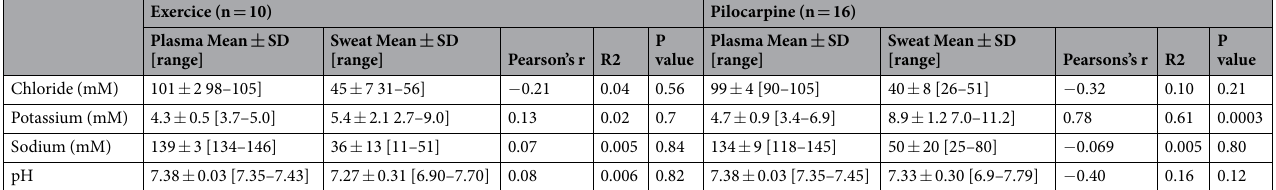
Table 1. Electrolyte concentrations and pH values in plasma and sweat of subjects: analysis. Sweat production was induced by cycling exercice in healthy subjects only (n = 10), and by pilocarpine iontophoresis in both healthy subjects and patients with end stage kidney disease (n = 6). Variables are expressed as mean ± standard deviation (SD) and range as indicated. Correlations were analysed using Pearson rank correlation coefficient. Linear regression was assessed and r2 value determined. A p value < 0.05 was considered